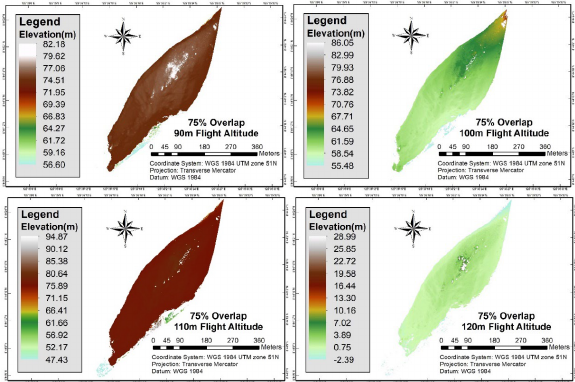
Figure 6 . Digital Terrain Models (DTMs) at 75% overlap generated using the acquired UAS data and disabled interpolated setting. T he white areas implied “no data”